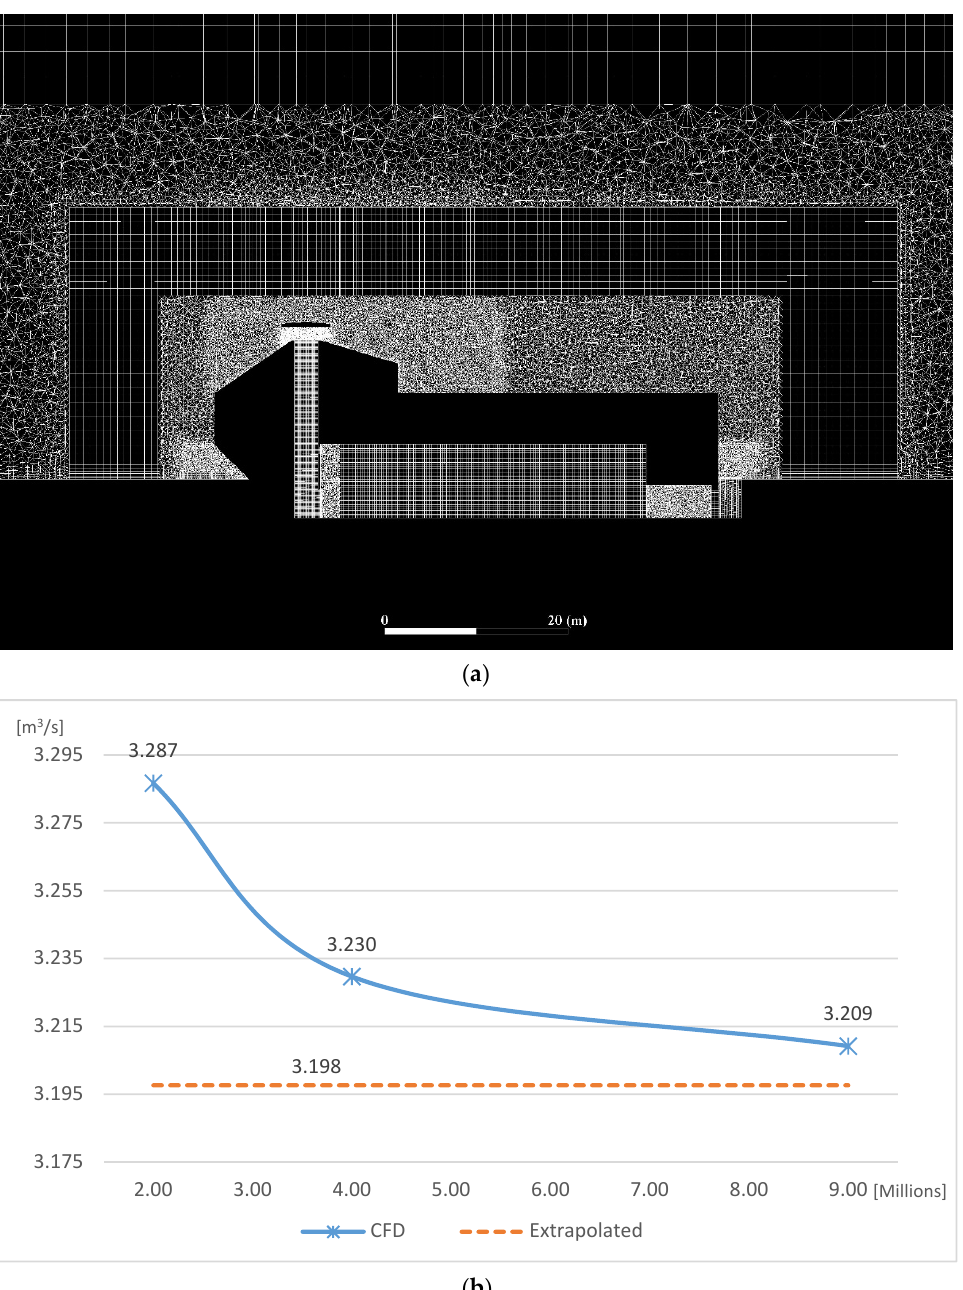
Figure 7. ( a ) Visualization of the highest grid resolution with 9.3 million cells and ( b ) grid refinement results of the three